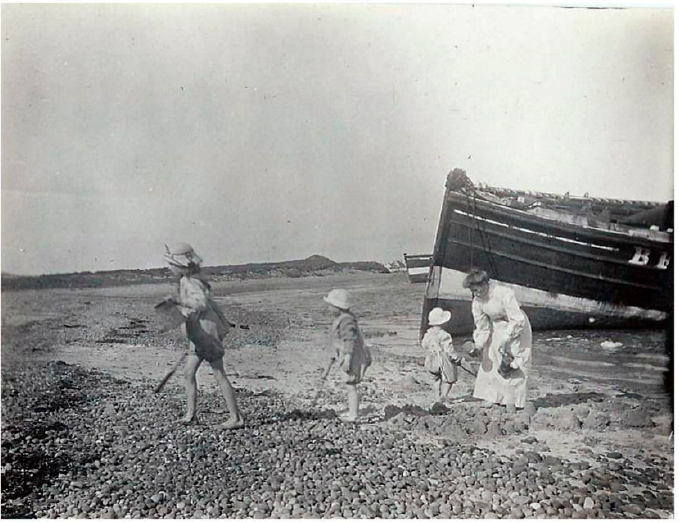
Figure 4. Findhorn Bay August 1913, showing herring boats hauled out on the shore. Photo from Forres Heritage / Henrietta Grant-Peterkin.